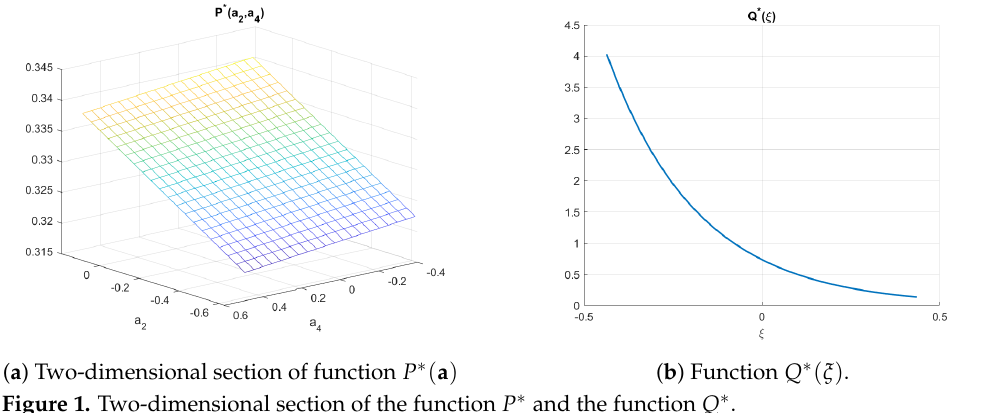
Figure 1. Two-dimensional section of the function P ∗ and the function Q ∗